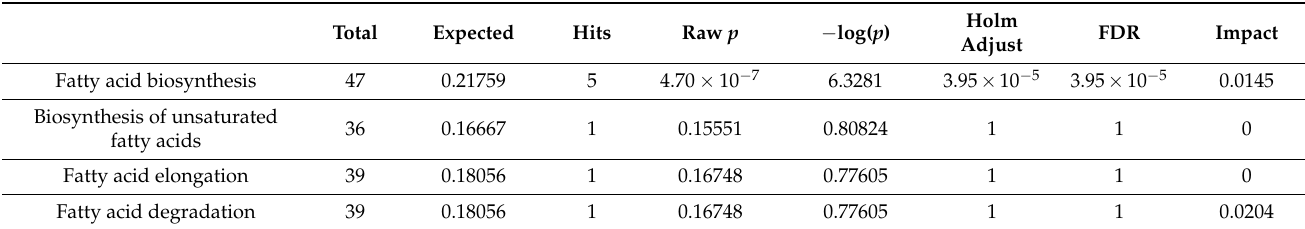
Table 3. Significant metabolic pathways ( p < 0.05) after single pathway analysis using Bos taurus as the